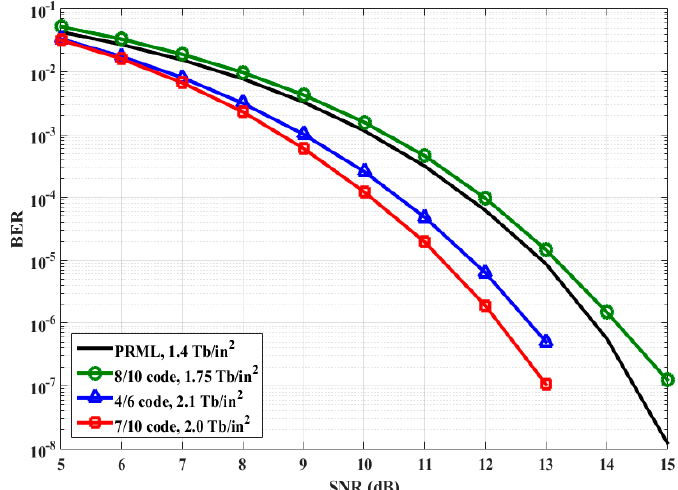
Figure 6. BER comparison with respect to modulation coding scheme at the user density (UD) = 1.4 Tb / in 2 . Table 3. The track pitch T z and bit period T x for each AD.